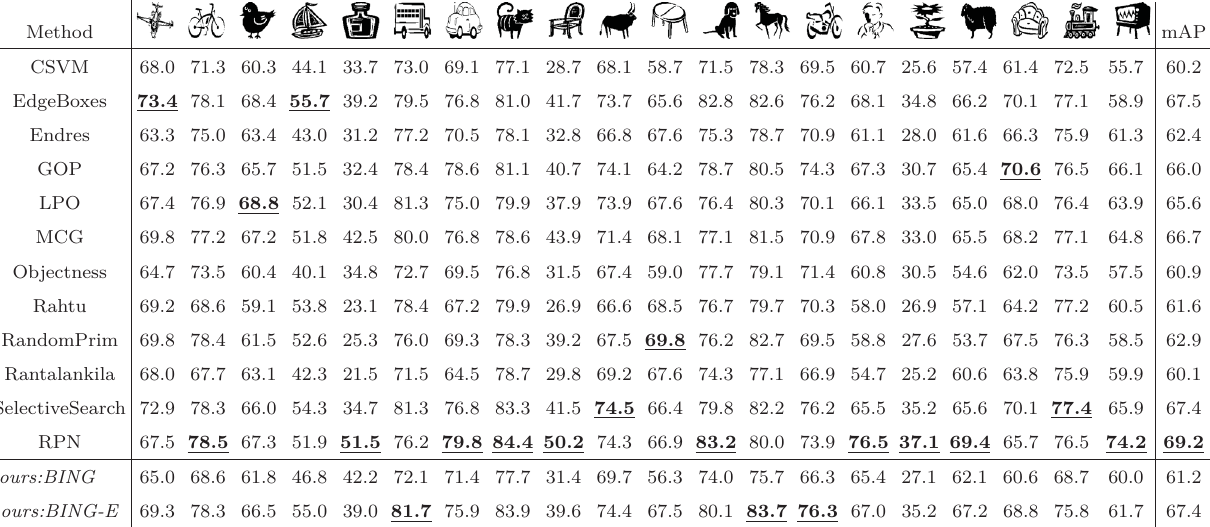
Table 5 Detection average precision (%) using fast R-CNN on the VOC2007 test set with 1000 proposals Method